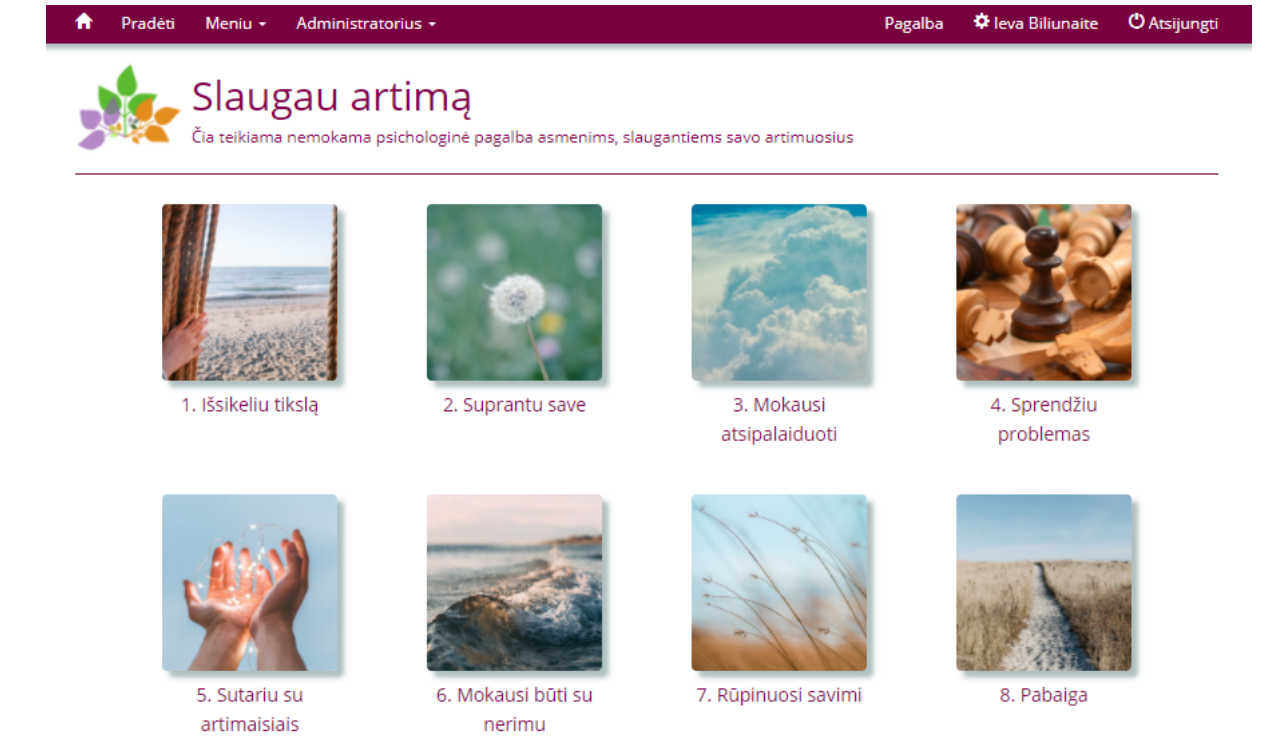
Figure 2. Screenshot of the eight intervention modules as presented to participants after logging